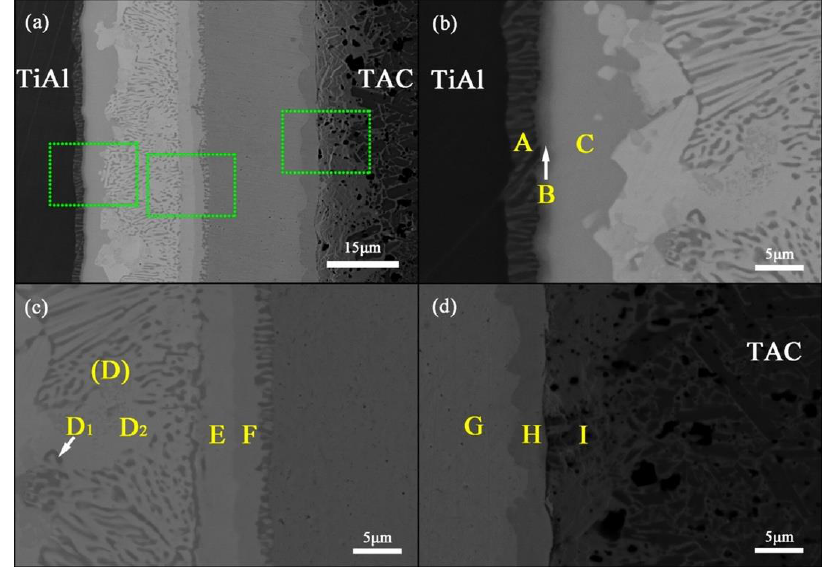
Figure 22. SEM images of TiAl/ Ti 3 AlC 2 joints bonded at 850 °C for 60 min: ( a ) Interfacial microstructure of the bonded joint, detailed information of ( b ) interface adjacent to TiAl base material, ( c ) interface center and ( d ) interface adjacent to Ti 3 AlC 2 base material, reproduced from Reference [51] with permission of Elsevier, 2014.